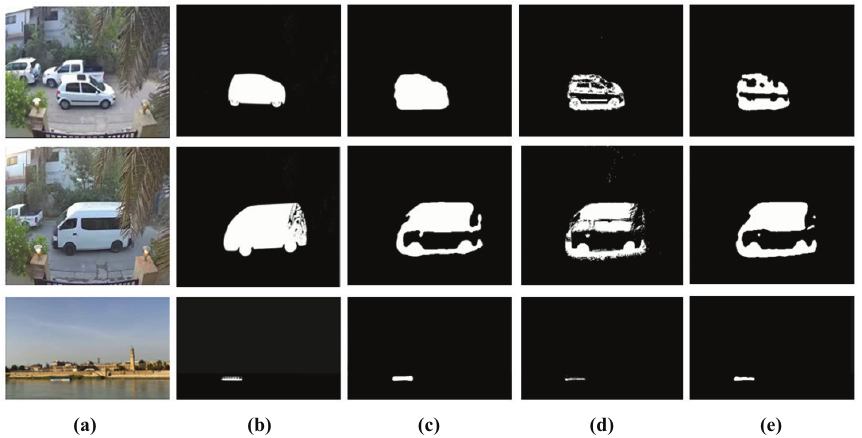
Fig. 7. Comparison of foreground detection results (a) original scenes (b) ground-truths (c) SuBSENSE subtraction (d) ViBe subtraction (e) LOBSTER